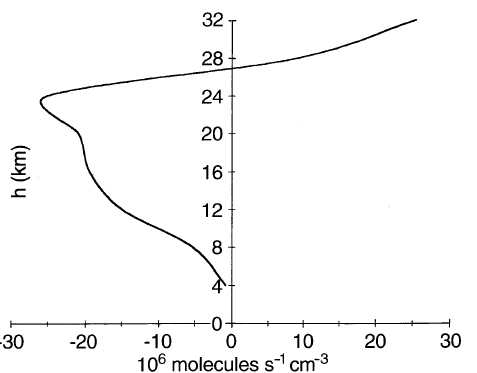
Fig. 8. 6 March 1993; contribution of meridional advection to the local variation of the ozone concentration as a function of height